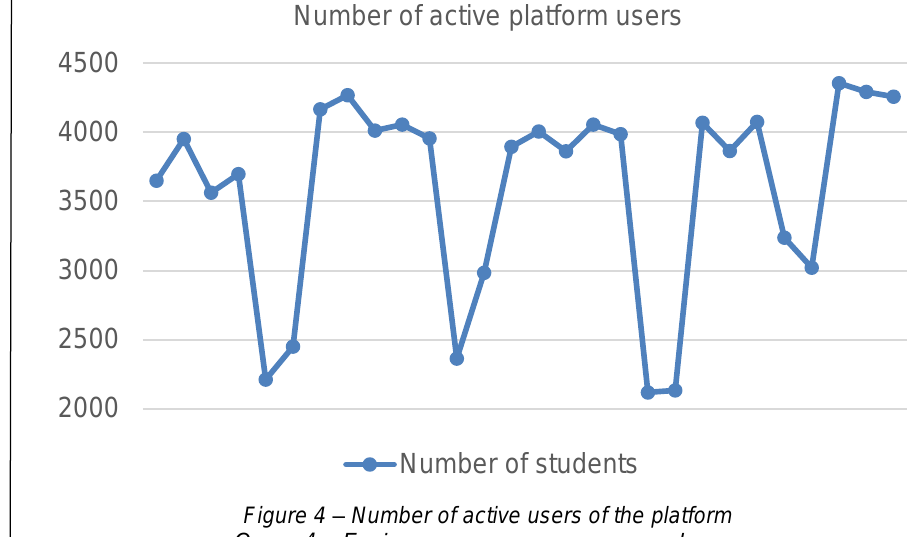
Figure 4 – Number of active users of the platform Слика 4 – Број активних корисника платформе Рис. 4 – Количество активных пользователей